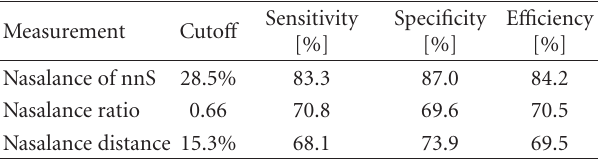
Table 3: Validation data for di ff erentiation between patients with regular resonance and hypernasal patients.